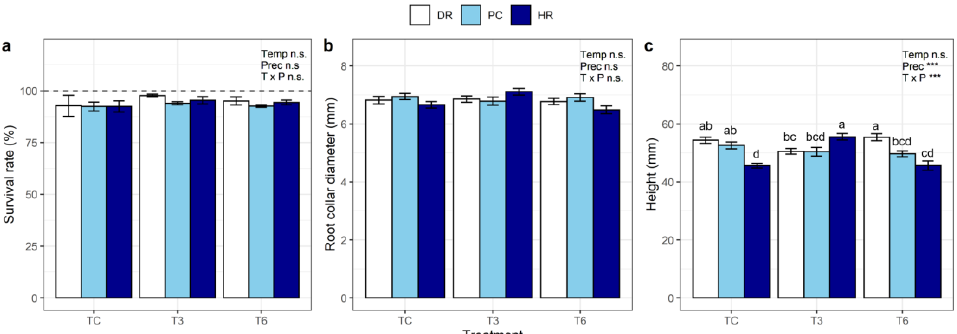
Figure 4. ( a ) Survival rate (%), ( b ) root collar diameter (mm), and ( c ) height (mm) of L. kaempferi seedlings subjected to extreme climate events, measured in October. TC: ambient temperature, T3: +3 °C warming, T6: +6 °C extreme warming, DR: drought, PC: ambient precipitation, HR: heavy rainfall. Results from two-way ANOVA are shown in each panel. Asterisks indicate significant differences between treatments; n.s.: not significant. Different letters in ( c ) indicate significant differences between treatments. Bars indicate standard errors of the mean.